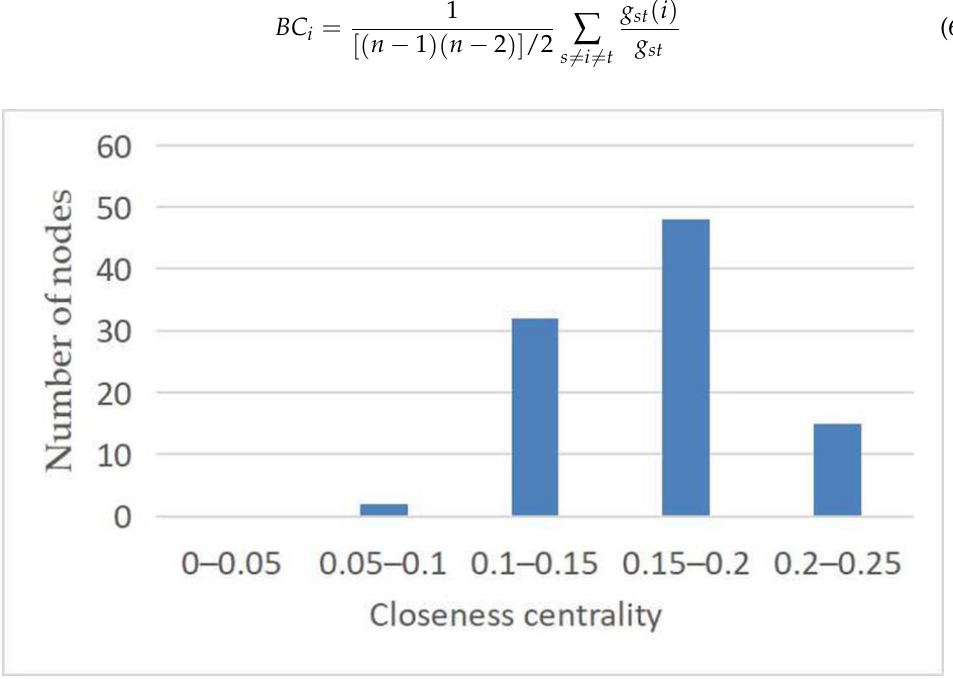
Figure 5. Closeness centrality of the traffic complex network.